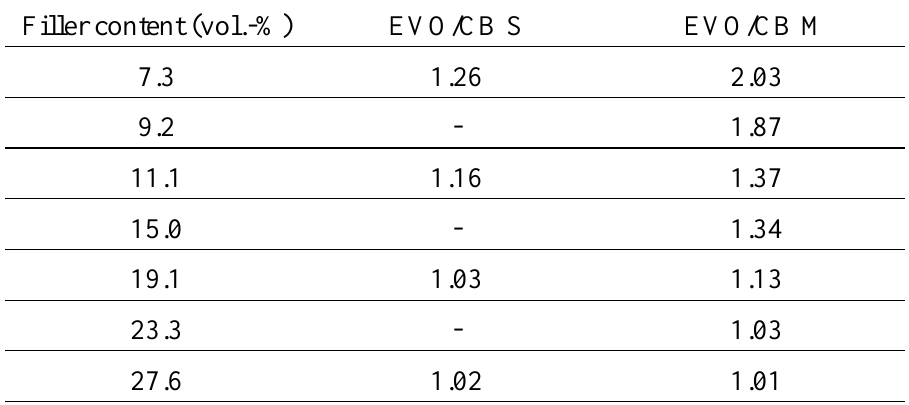
Table 4. Values of n for EVO/CB S and EVO/CB M composites with various filler contents. Filler content